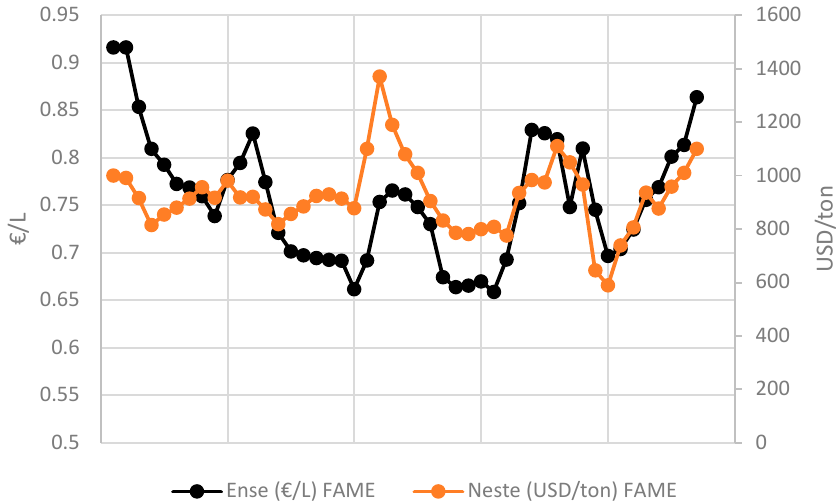
Figure 3. Market price of biodiesel (source: Ense and Neste [74]). Monthly prices since January 2017 until December 2020.